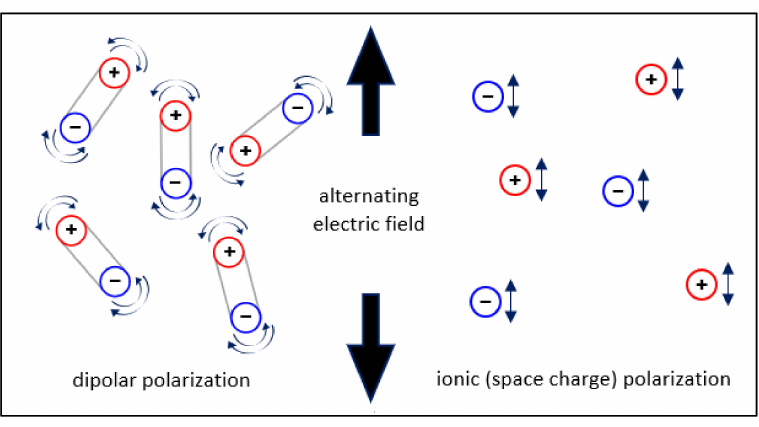
Figure 1. Molecular and ionic movements under microwave